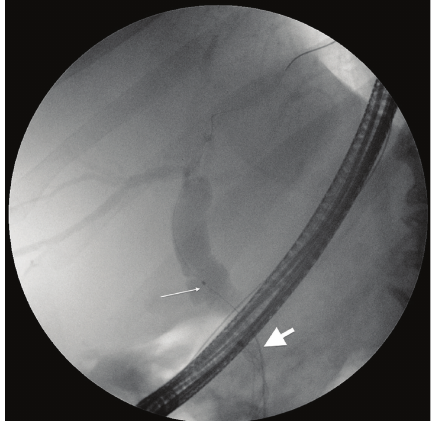
Figure 4: Insertion of a wire guided 8.5 Fr dilating catheter (thin arrow) beside the basket/stone complex (thick arrow) in the